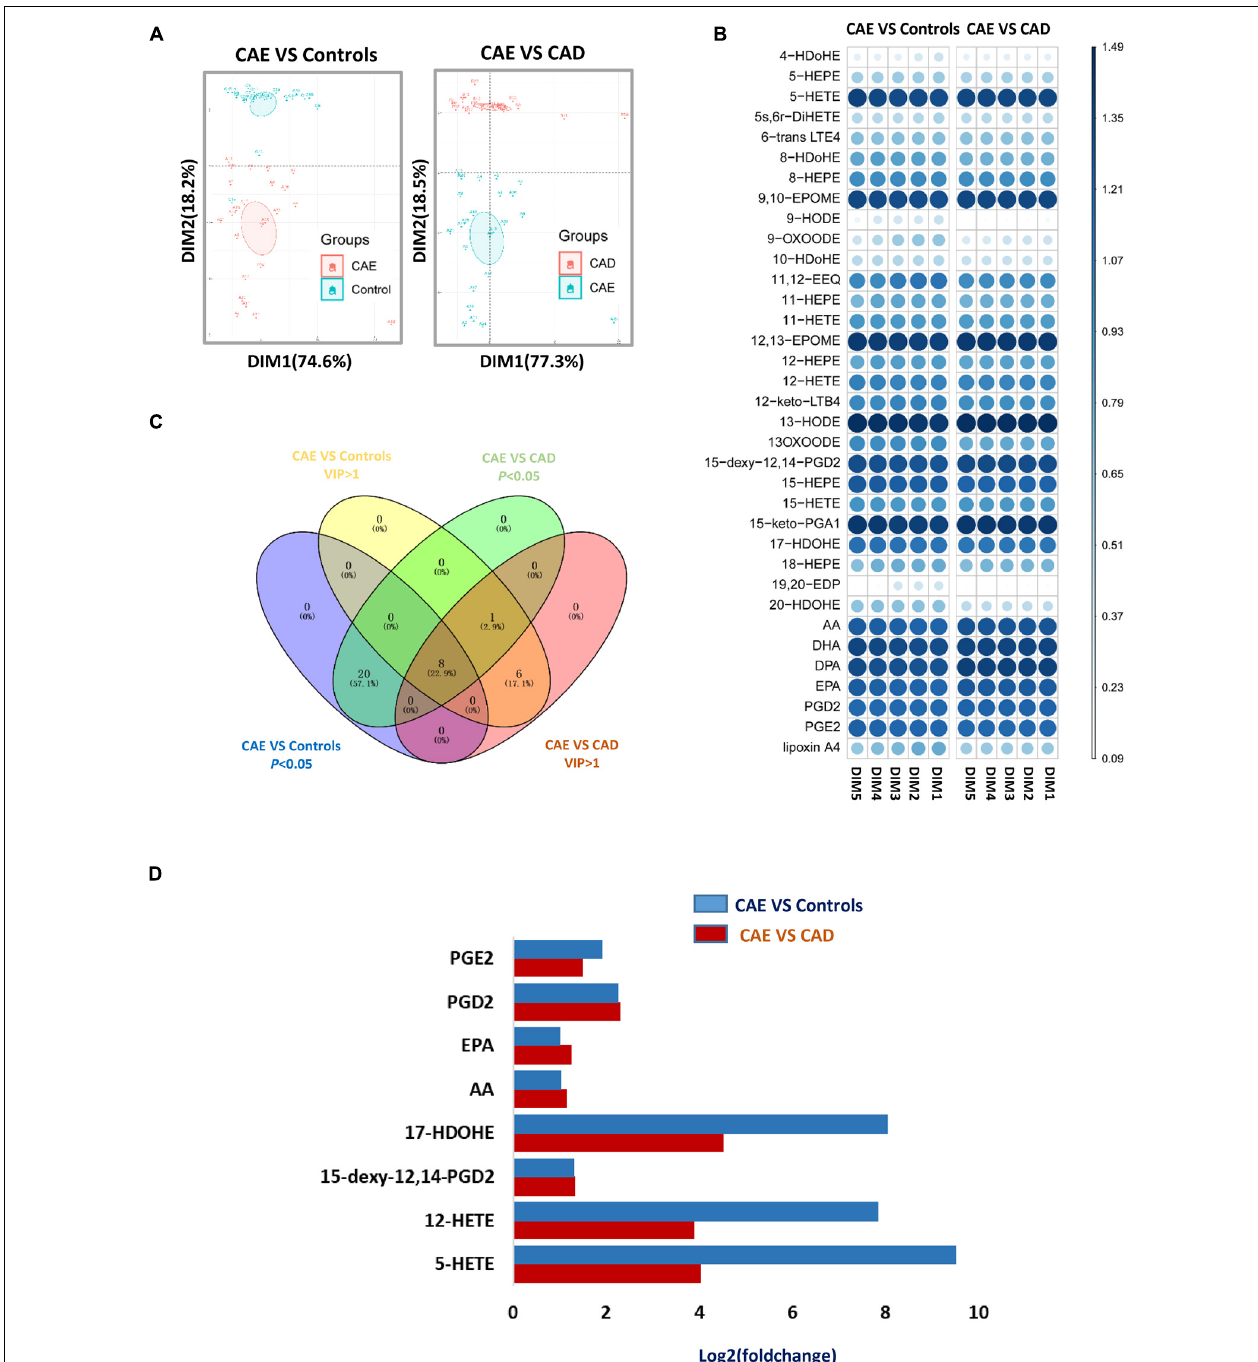
FIGURE 3 | Defining of a potential metabolic biomarker for CAE. (A) Score plot of the first (PC1) and second (PC2) PCs (horizontal and vertical axes, respectively) from principal component analysis of arachidonic acid metabolites in discovery sets. (B) VIP value of metabolites from PCA analysis in discovery sets. (C) Venn diagram shows an overlap between metabolites with VIP value > 1 and P -value < 0.05. (D) Fold change of eight serum metabolites from C in discovery sets. CAE, coronary artery ectasia; PCA, principal component analysis.